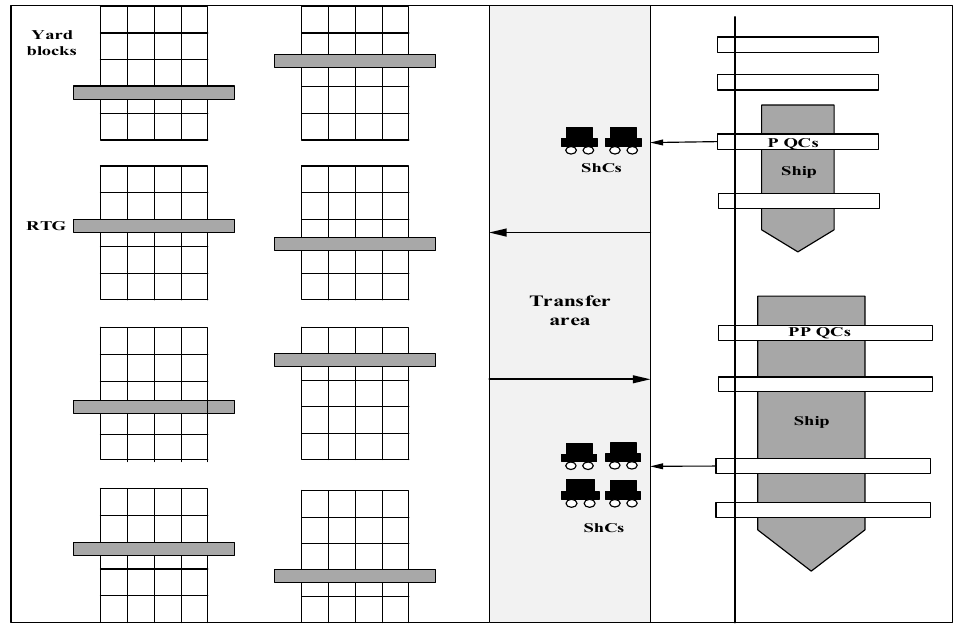
Figure 1. Model layout.